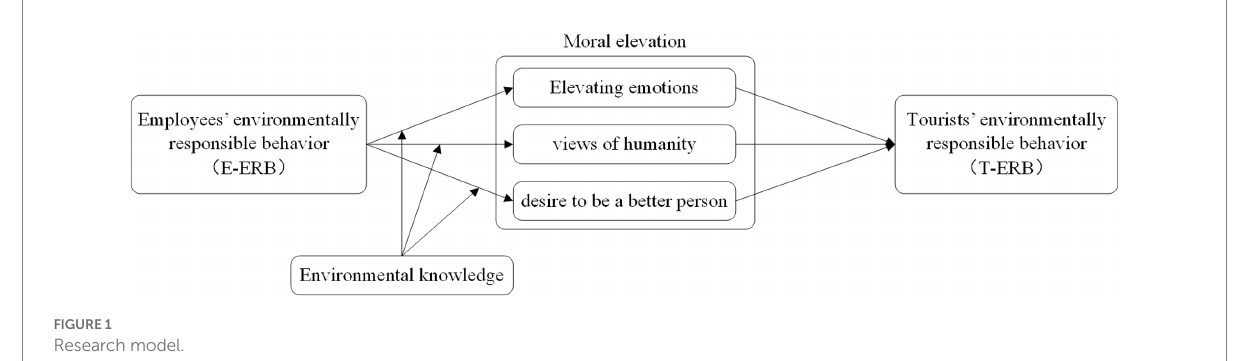
FIGURE 1 Research